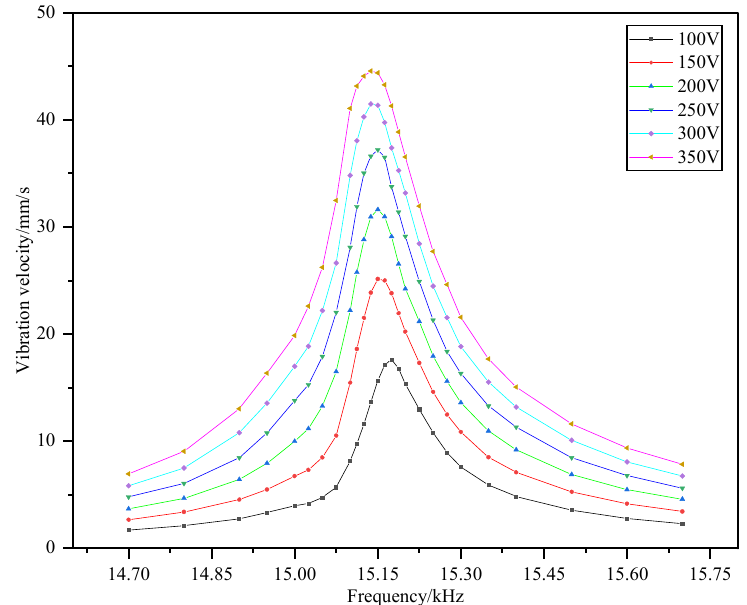
Figure 9. Power transducer frequency characteristic curve.